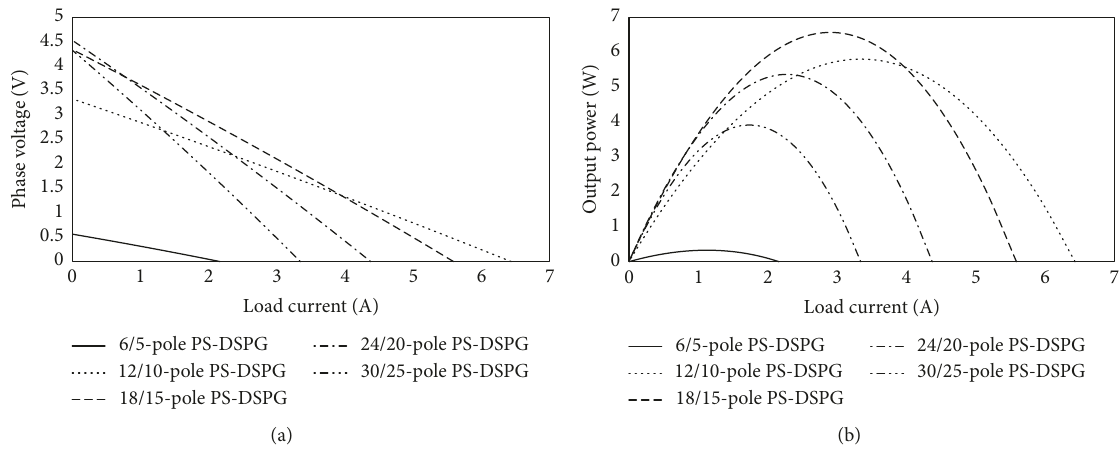
Figure 7: Output characteristics of proposed PS-DSPG structures: (a) voltage regulation and (b) output